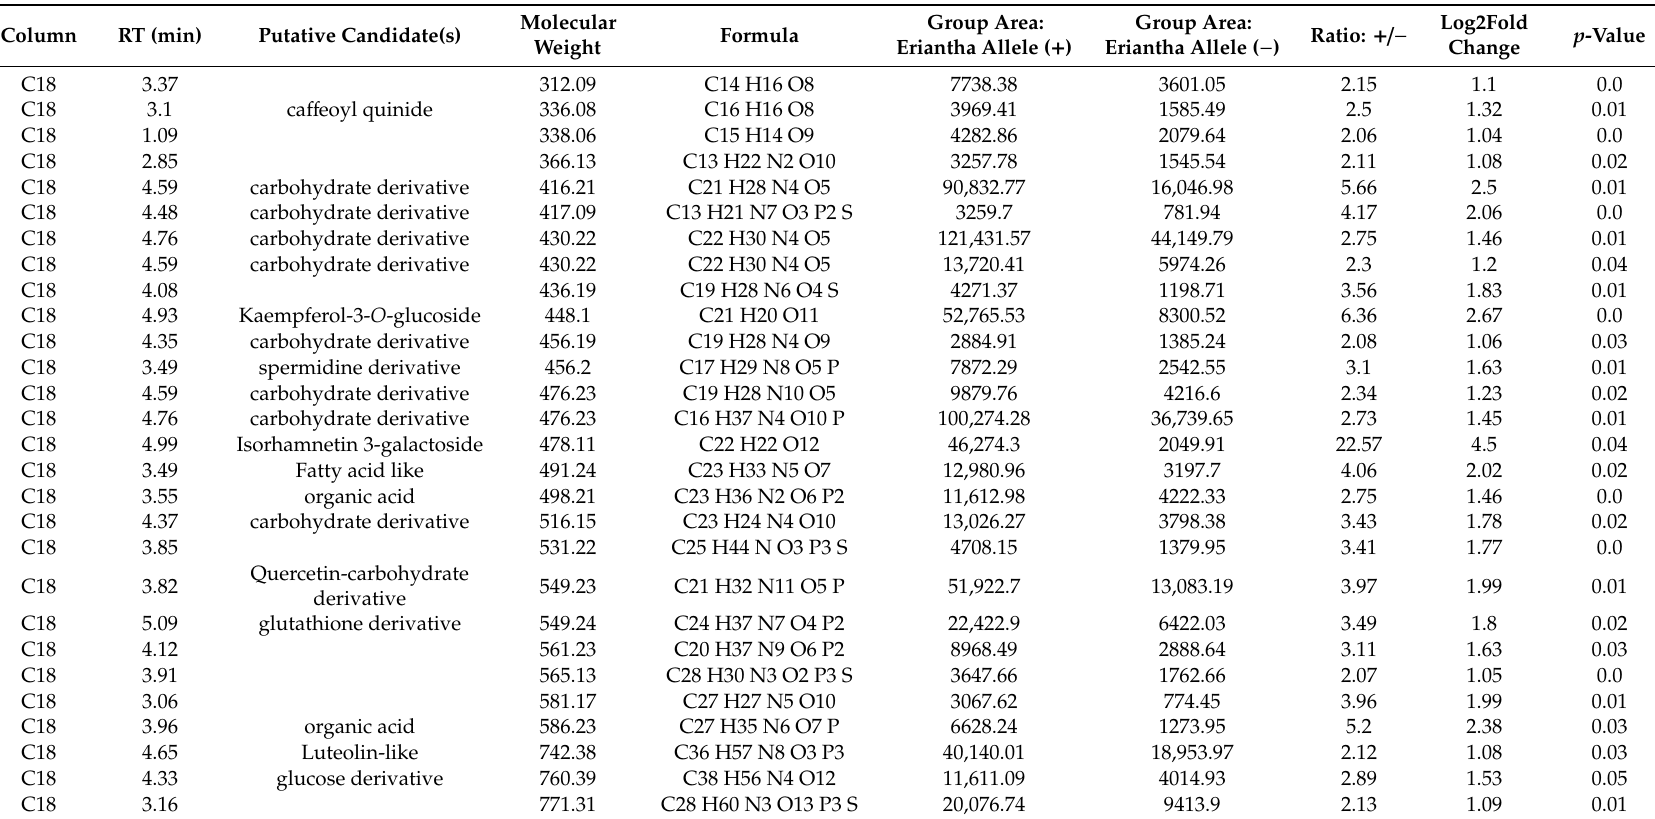
Table 2. Putative identities and molecular formulae of metabolites exhibiting di ff erence at p < 0.05 based on untargeted metabolomics. The samples comprised a total of N = 130 leaf samples (no technical replication) from diploid backcross AI247 and AJ247 vines with (N = 65) or without (N = 65) the A. eriantha allele for marker